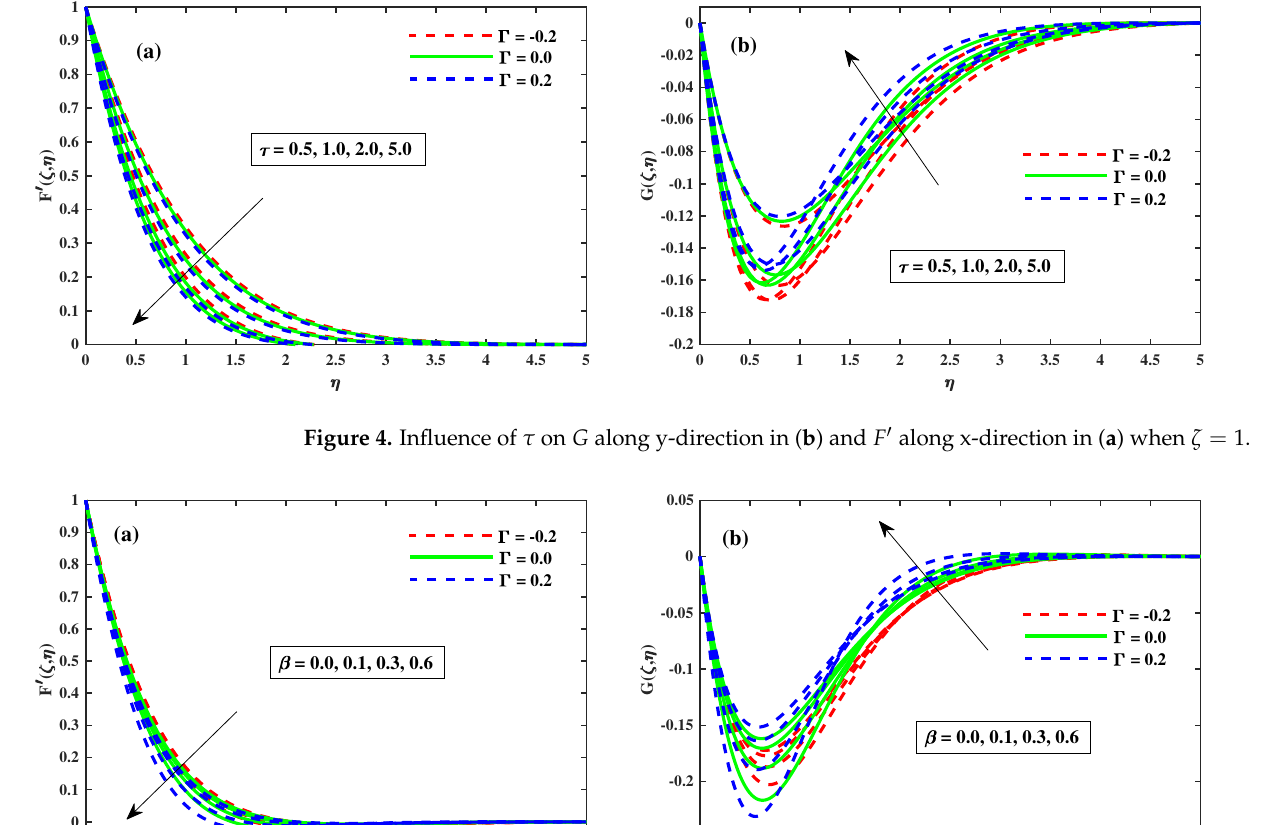
√ Re x (friction factor) across the transverse and x